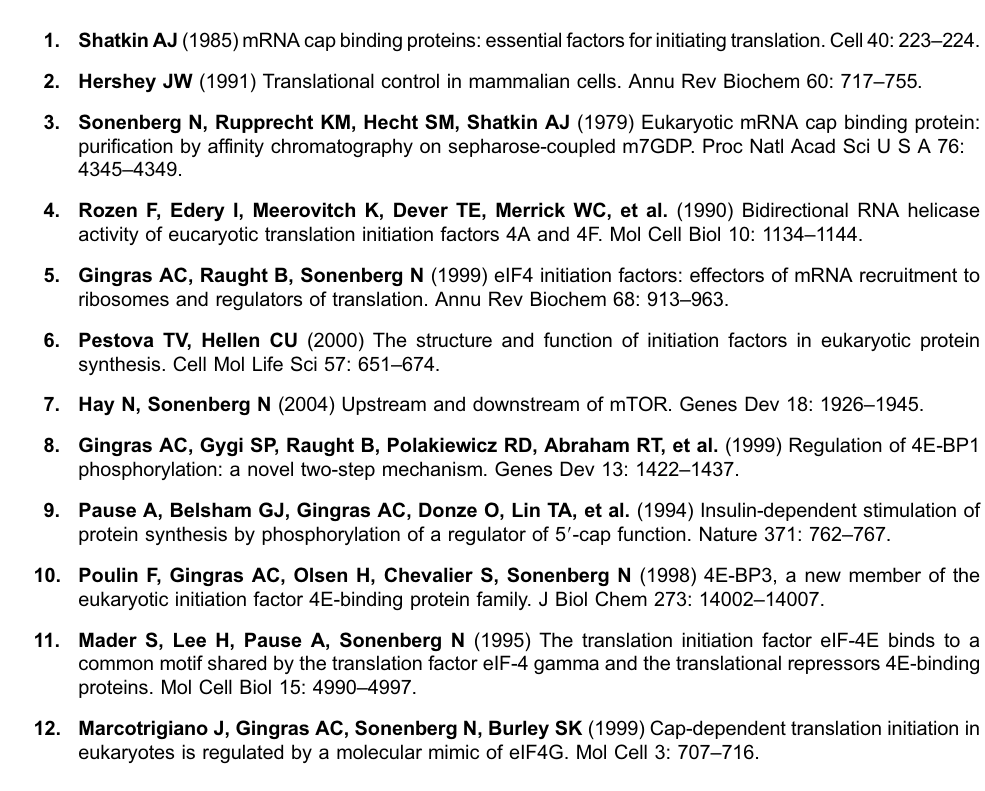
S1 Fig. Knockdown of 4E-BPs in HeLa cells, (A) Fluorescent microscopy of HeLa cells infected with VSV-GFP. (B) Western blotting analysis showing the kinetics of VSV protein expression following 4E-BP